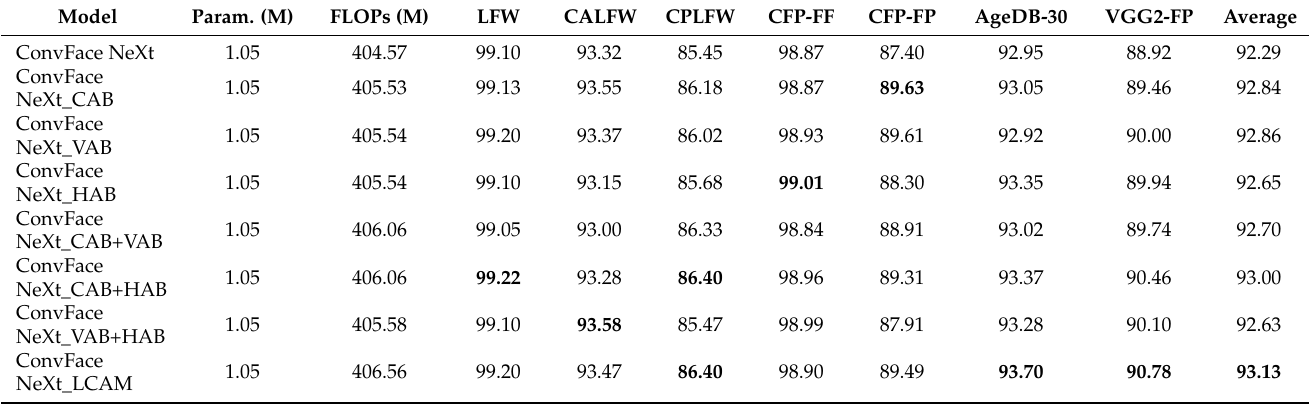
Table 3. Performance results on different combination of branches. These results are reported in terms of parameters, FLOPs, and verification accuracy for LFW, CALFW, CPLFW, CFP-FF, CFP-FP, AgeDB-30, and VGG2-FP. Moreover, the average accuracy for the seven image-based datasets is shown in the last column. (Bold values are the highest obtained values by the